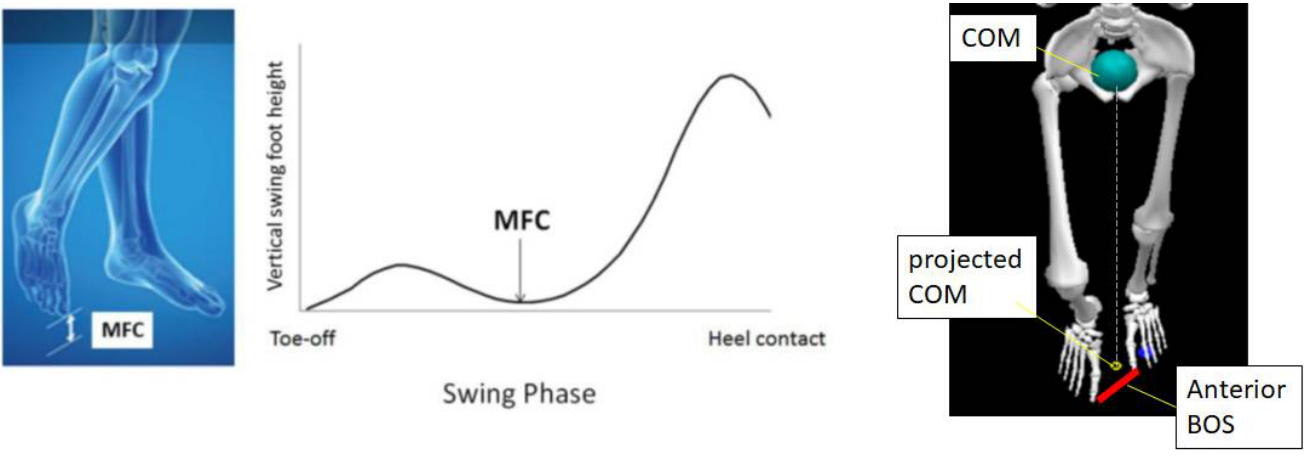
Figure 2. ( Left ) Illustration of minimum foot clearance (MFC) and swing foot clearance graph [38]; ( right ) frontal plane illustration at MFC, COM = centre of mass, BOS = base of support, BOS boundary indicating the line between the toes (frontal BOS boundary).